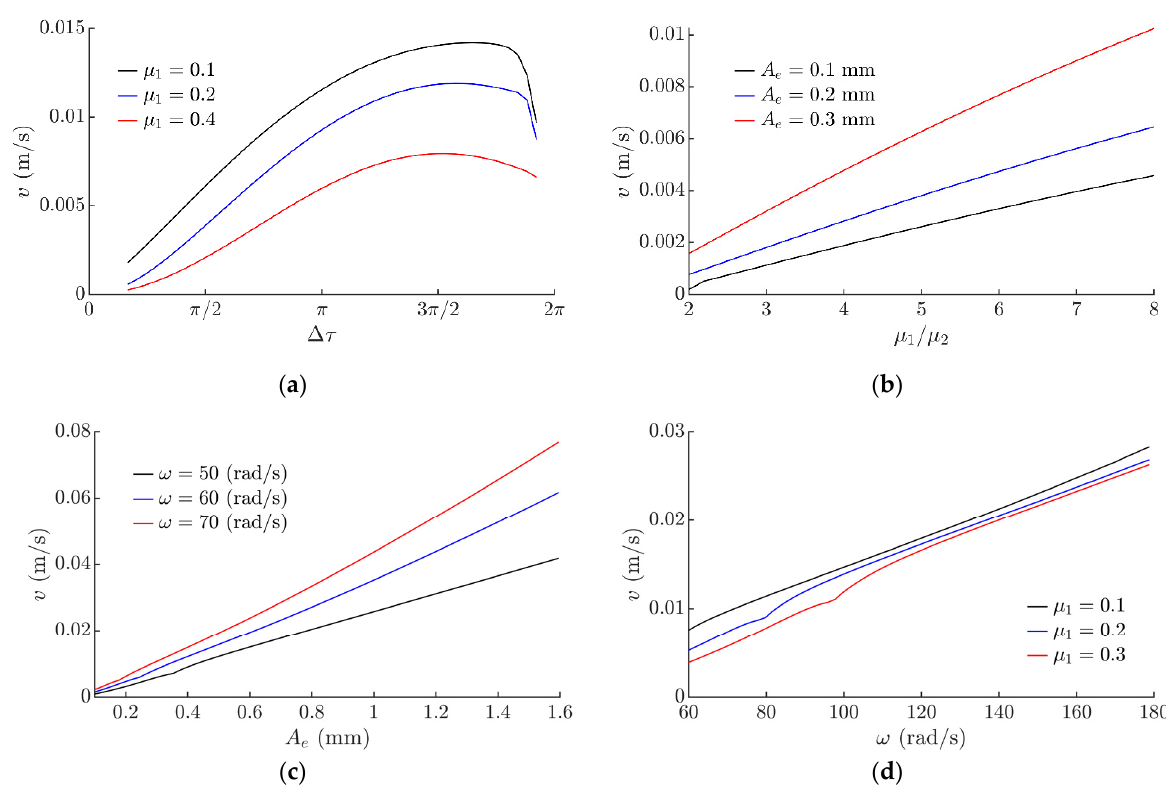
Figure 6. Mean displacement velocity depending on: ( a ) Δ τ when μ 2 = μ 1 /8, g = 9.81 m/s 2 , A e = 0.28 mm, ω = 62.8 rad/s, ε = π /2, ϕ = 0; ( b ) μ 1 / μ 2 when μ 1 = 0.1, g = 9.81 m/s 2 , ω = 62.8 rad/s, ε = π /2, ϕ = 0, Δ τ = π /6; ( c ) circular excitation amplitude A e when μ 1 = 0.1, μ 2 = μ 1 /8, g = 9.81 m/s 2 , ε = π /2, ϕ = π /2, Δ τ = 2 π /3; ( d ) circular excitation frequency ω when μ 2 = μ 1 /8, g = 9.81 m/s 2 , ε = π /2, A e = 0.28 mm, ϕ = π /2, Δ τ = 2 π /3.